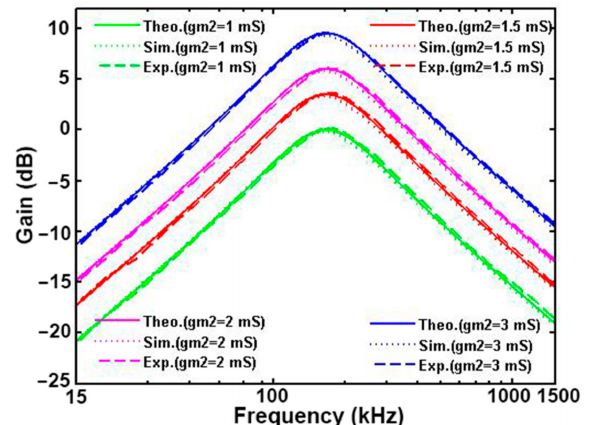
Figure 27. The theoretical, simulated and measured NBPF responses at the voltage output of V BP5 when g m2 was varied.